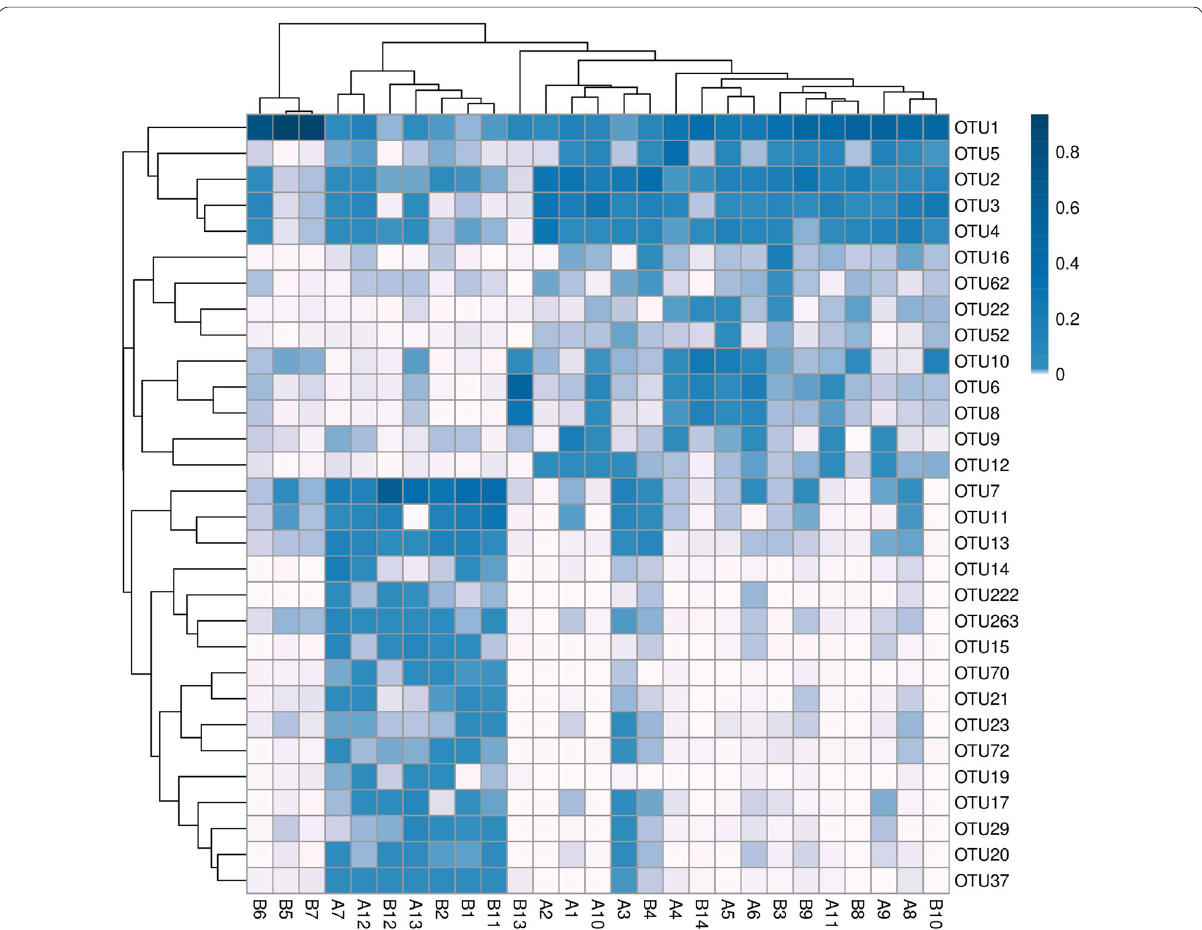
Table 2 Diversity estimation of the 16S rRNA gene libraries of the 27 samples from the 16S rRNA sequences